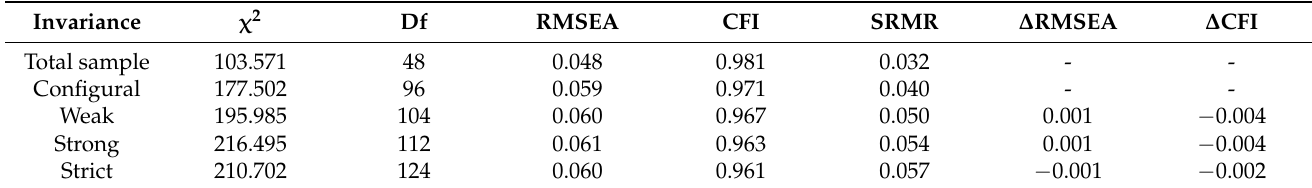
Table 1. Measurement invariance between male and female groups.